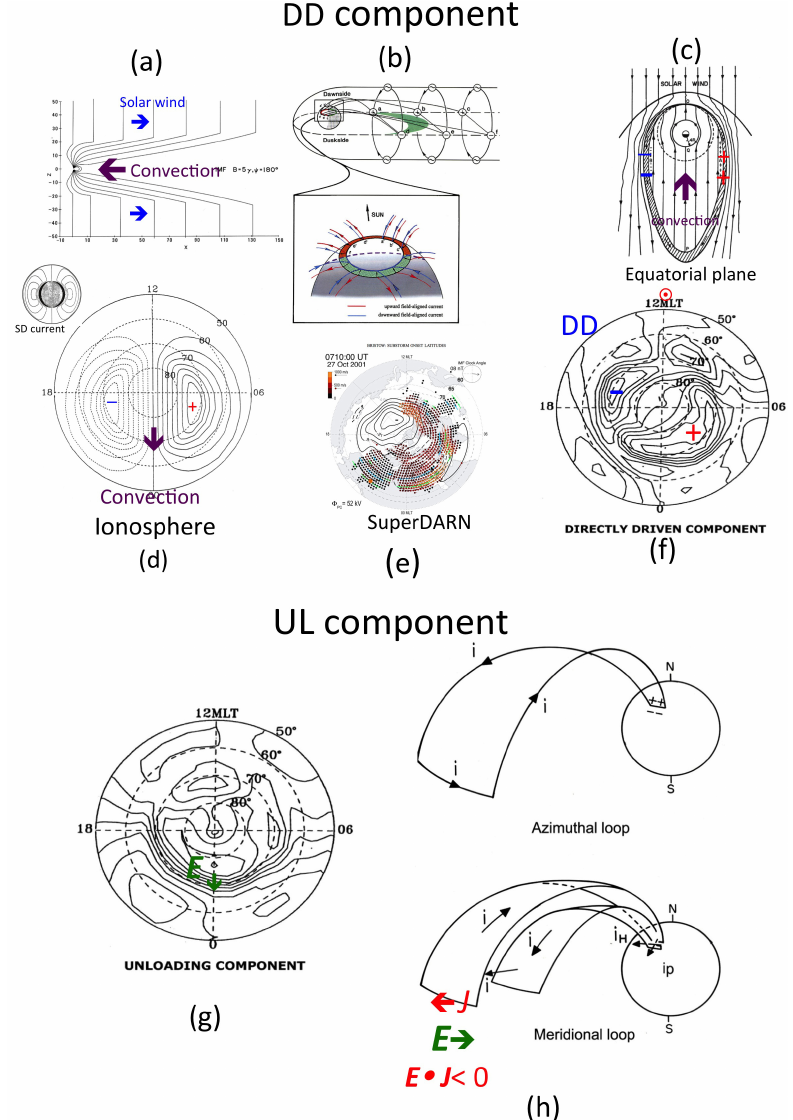
Figure 5. The DD current: (a) the solar wind–magnetosphere interaction; (b) a schematic illustration of the circuit; (c) the resulting con- vection pattern of magnetospheric plasmas (Axford and Hines, 1961); (d) the expected convection pattern of ionospheric plasma, which is basically the equipotential pattern (Akasofu, 2017); (e) SuperDARN result (Bristow and Jensen, 2007); (f) the realistic ionospheric DD current (convection) derived from the magnetometer data (Akasofu, 2017). The UL current: (g) the UL component of the ionospheric current (Akasofu, 2017); (h) Bostrom’s 3-D current system made up of azimuthal and meridional components (Akasofu,